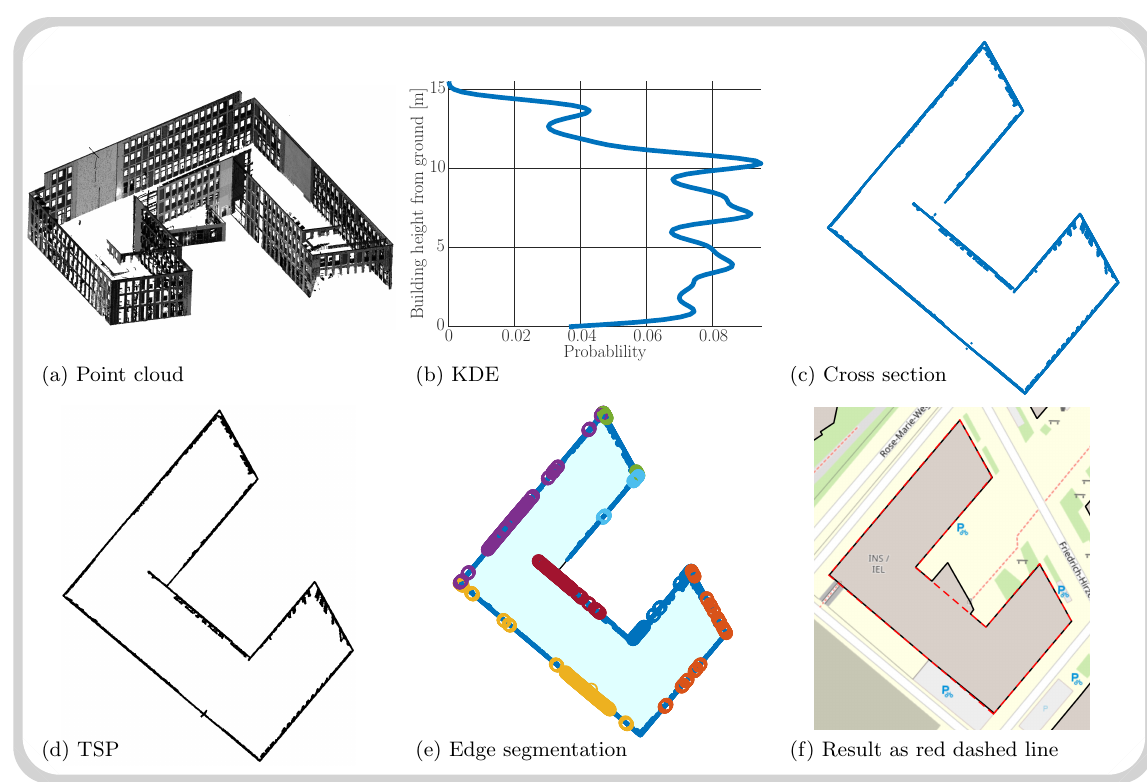
Figure 5: The pipeline of our approach demonstrated on the U NIVERSITY campus in Bonn/Germany. The skillfully selection of the cross section (c) based on a kernel density estimation (b), is a decisive prior to solve a travelling salesperson problem (d) followed by an edge segmentation (e) and leading to a final footprint (f) of high